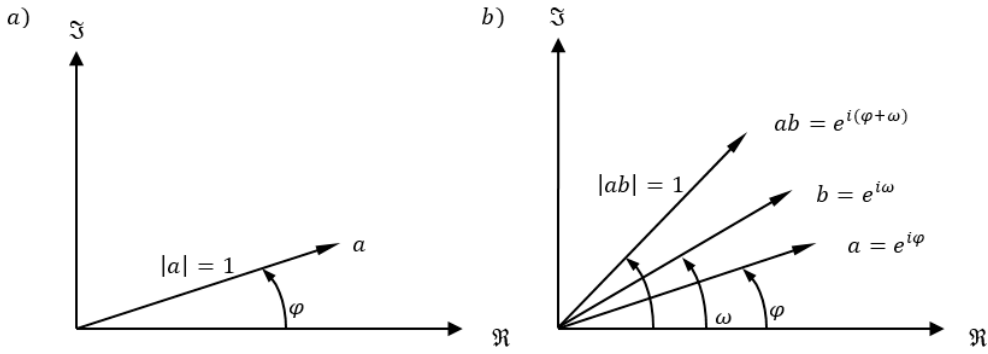
Figure A1. Complex value ( a ) a in 𝑟 − 𝜑 notation, and ( b ) product of a and b.